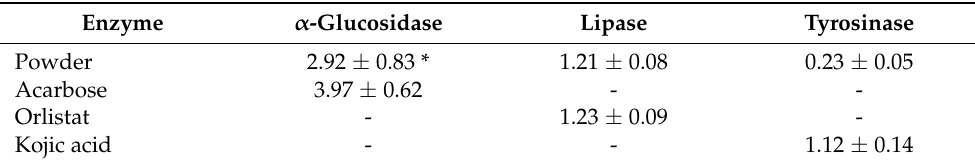
Table 9. The inhibitory activity (IC50, mg/mL) of freeze-dried Lactobacillus acidophilus inoculated powder based on rosehip fruits